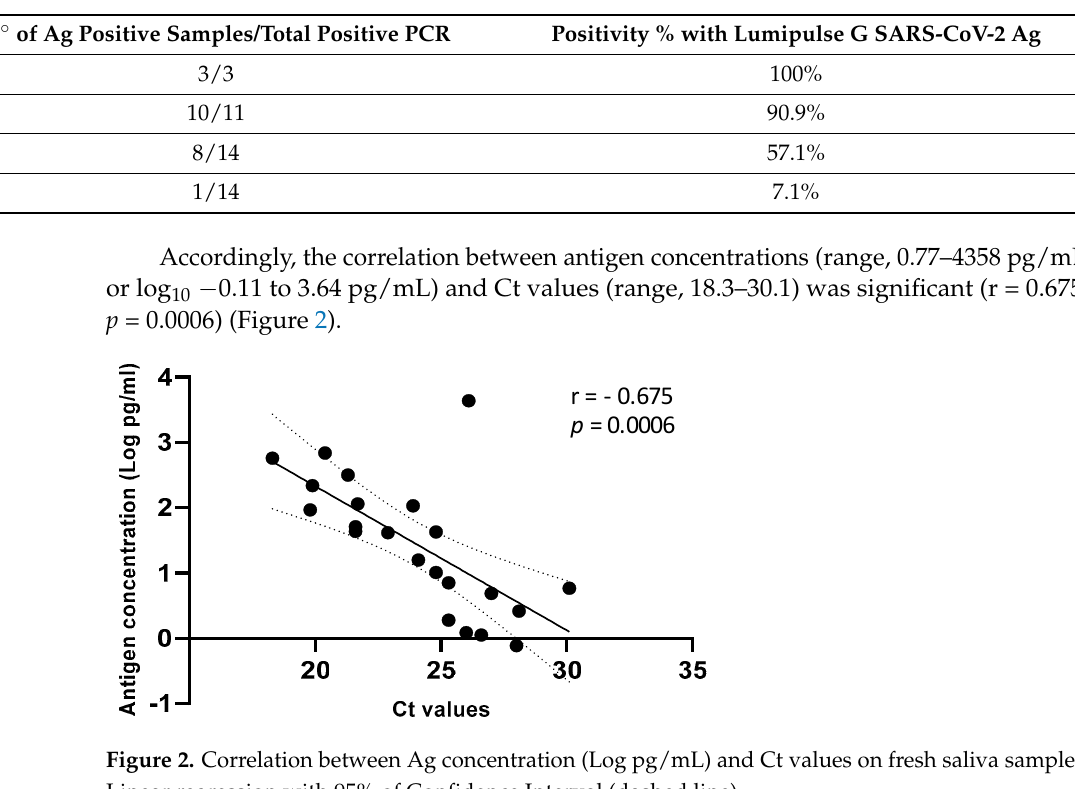
Table 6. Percentage of positivity of fresh saliva samples based on Ct ranges.